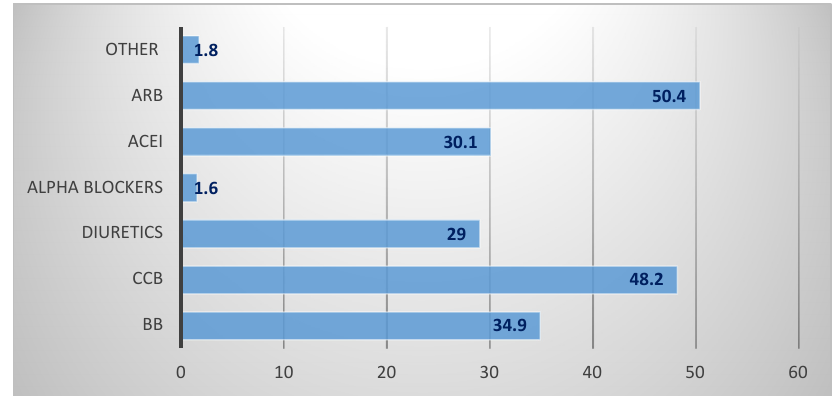
Figure 2. Treatment profile in medicated patients ( n = 677). ACEI, angiotensin-converting enzyme inhibitors; ARB, angiotensin receptor blockers; BB, beta-blockers; CCB, calcium channel blockers.